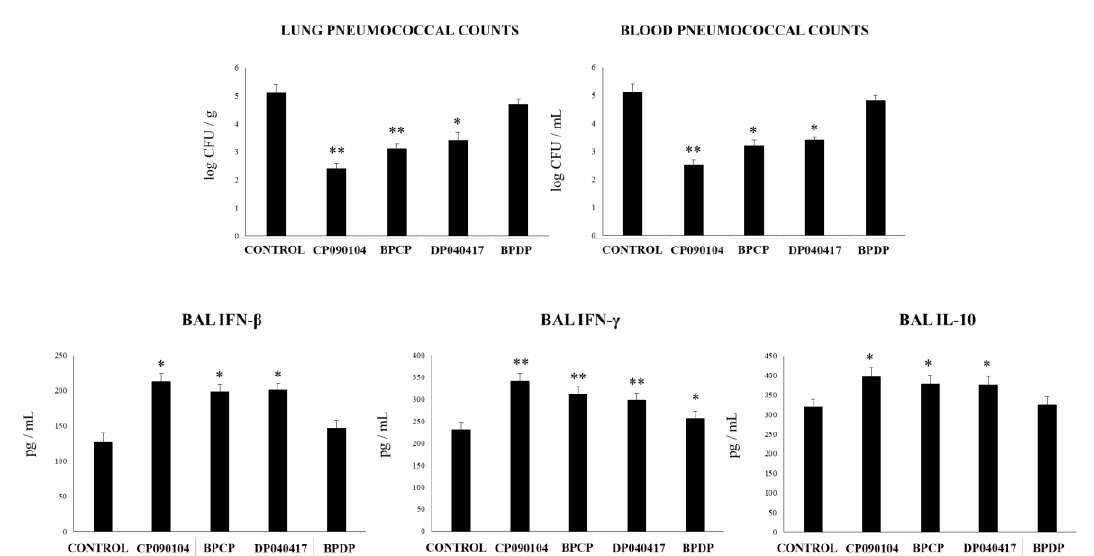
Figure 12. E ff ect of Dolosigranulum pigrum 040417 and Corynebacterium pseudodiphteriticum 090104 on the resistance and immune response to Streptococcus pneumoniae infection. Infant mice were nasally primed with viable (DP) or bacterium-like particles (BPDP) from D. pigrum 040417, or viable (CP) or bacterium-like particles (BPCP) from C. pseudodiphteriticum 090104 during five consecutive days and then challenged with pneumococci. Non-treated infant mice challenged with the bacterial pathogen were used as controls. Lung and blood pneumococcal cell counts and the levels of interferon (IFN)- β , IFN- γ , and interleukin (IL)-10 were determined in broncho-alveolar lavages (BAL) on day two post-infection. Experiments were performed with 5–6 mice per group per each time point. The results represent data from three independent experiments. Significantly di ff erent when compared to control * p < 0.05 and ** p < 0.01.